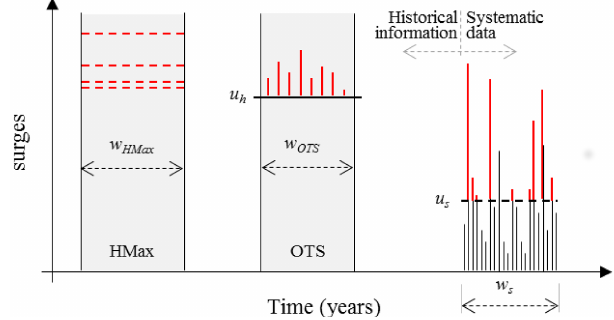
Figure 3. POTH: a sketch of systematic records and historical in- formation (HMax and OTS